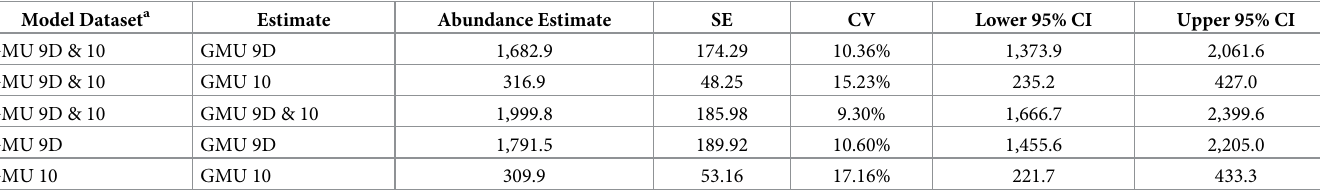
Table 4. Brown bear abundance estimates, standard errors, coefficients of variation, and confidence intervals for Game Management Unit (GMU) 9D, for GMU 10, and for GMUs 9D and 10 combined, Southwest, Alaska. Line transect survey conducted 29 May to 11 June 2002. Model Dataset